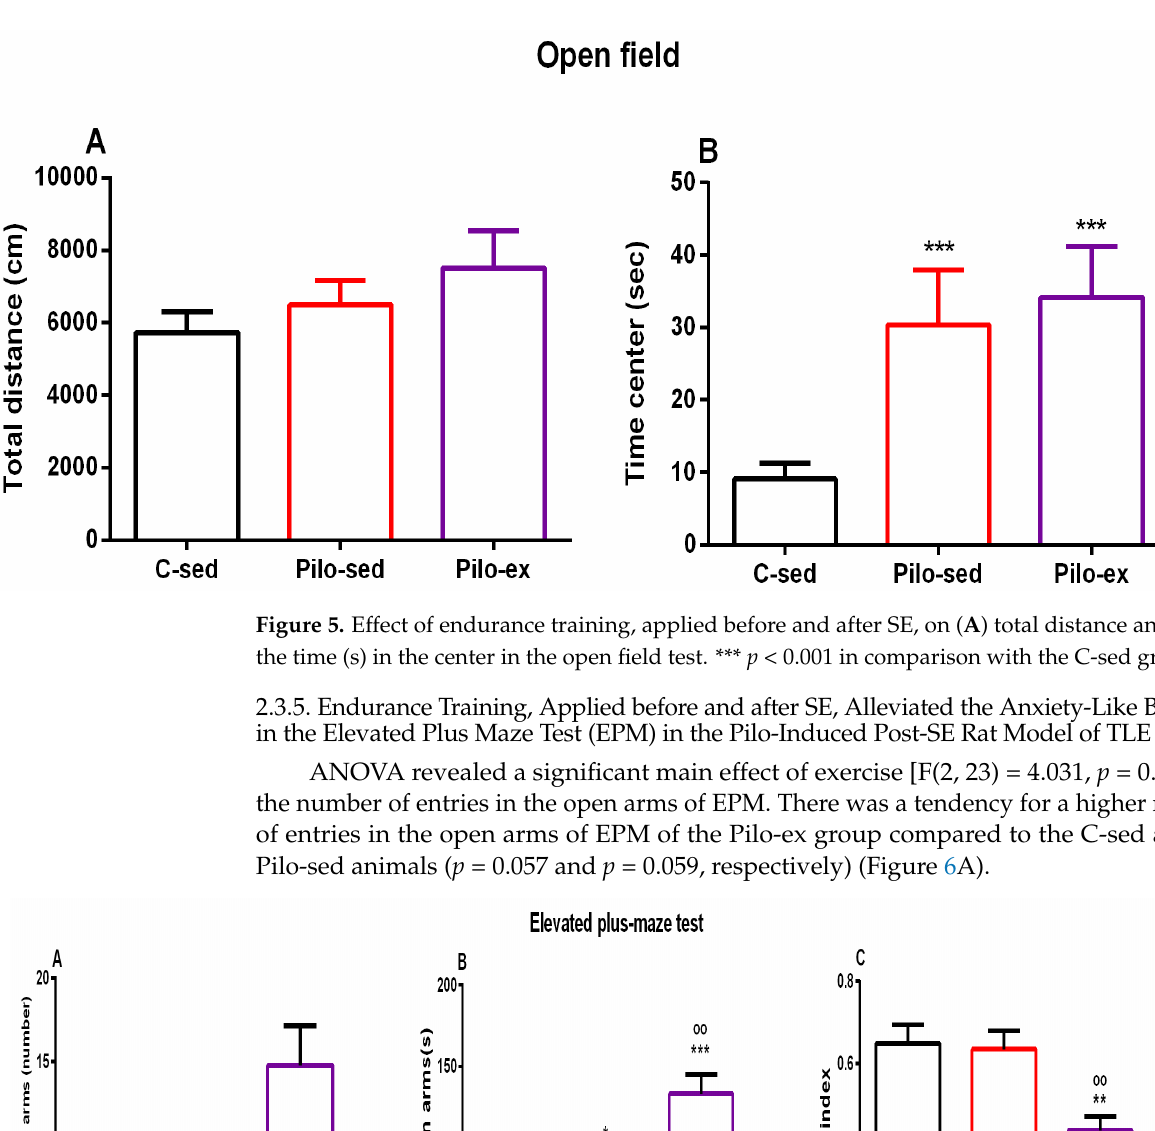
iety index compared to the C-sed ( p = 0.005) and the Pilo-sed groups ( p = 0.009) (Figure 6C).